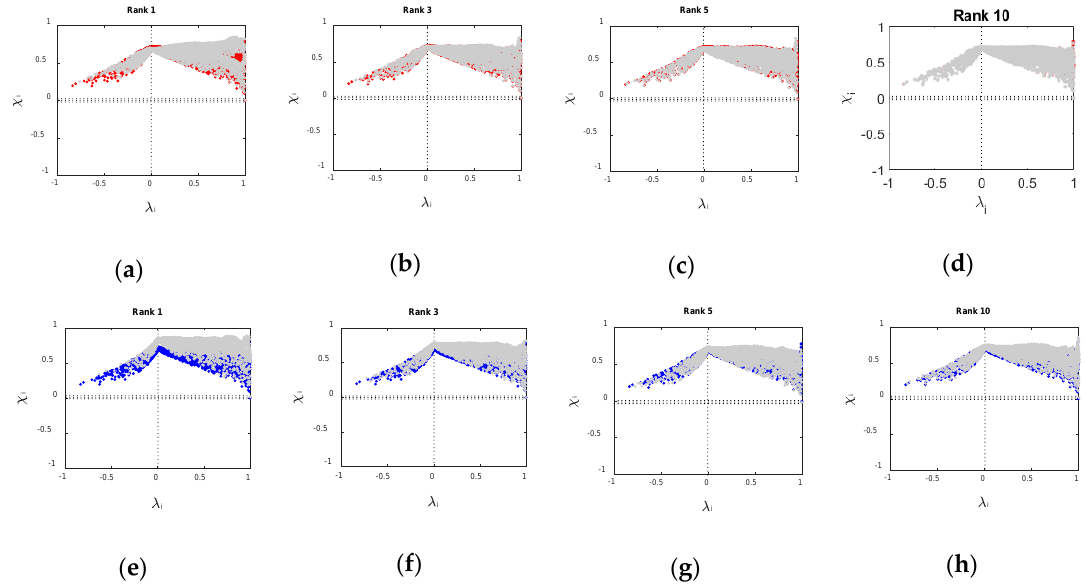
Figure 7. Chi-plots of the maximum annual peak-flow and volume. Grey dots represent the values obtained considering specific storm orders up to different ranks ( a , e ) rank one ( b , f ) rank three, ( c , g ) rank five, ( d , h ) rank ten). Color dots represent the values obtained from the continuous simulation (red in ( a – d ), blue ( e – h )). Storm rank criteria are total depth in ( a – d ) and maximum intensity in ( e – h ). To numerically compare the degree of dependence of the peak-flow and volume of the continuous simulation with respect to different storm ranks, values of Spearman’s rho and Kendall’s tau were computed (Table 5), and their RE (Equation (2)). In the case of the V Event criterion, all the absolute values of RE obtained from the different ranks are lower than 1%, whereas in the case of I max , the absolute RE values are over 2% for storms up to rank five, reaching absolute RE values of less than 1% if only storms up to rank ten are considered. Table 5. Rank-based non-parametric measures of dependence Spearman’s rho (ρ) and Kendall’s tau (τ) for the pair of values of maximum annual peak -flows and maximum annual volumes regarding the maximum storm rank considered and to the criteria used: Total depth or maximum intensity.